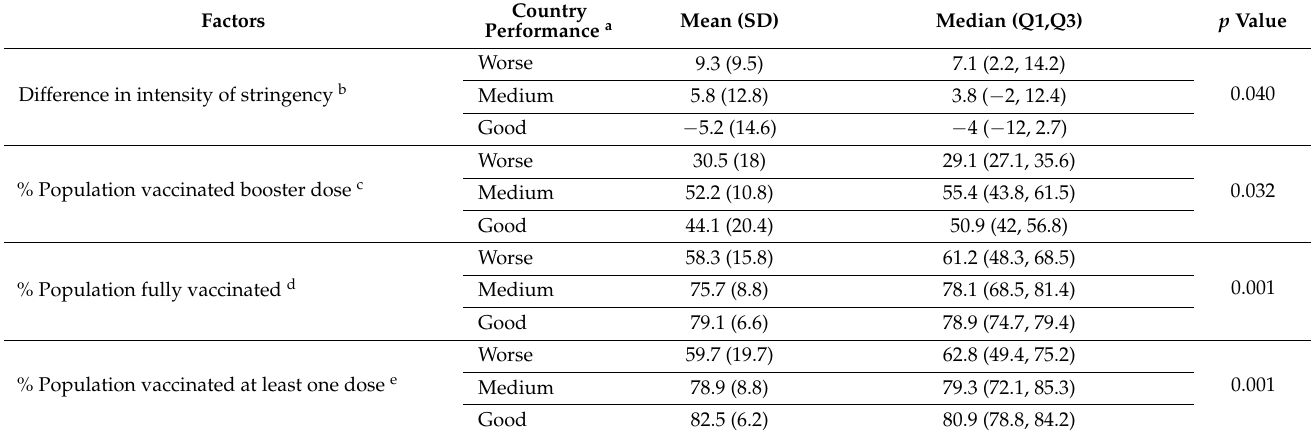
Table 4. Characteristics of countries having worse, medium and better performance in terms of COVID-19 resilience